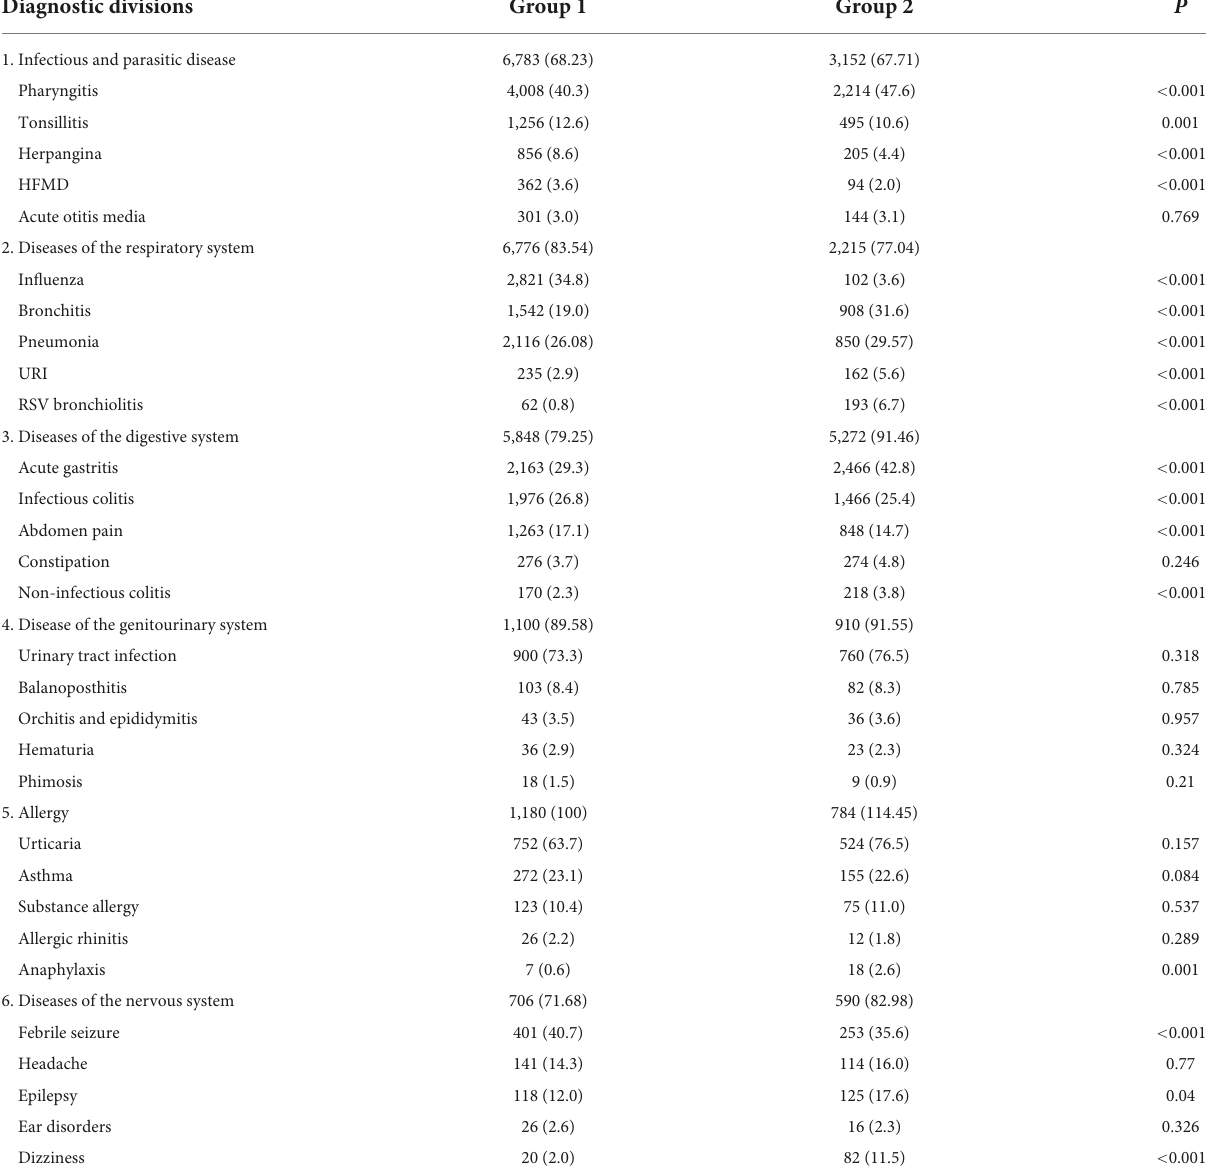
TABLE 2 Common disease and five frequency diagnostic divisions during the 2020 COVID-19 pandemic period vs. the 2019 period [values are n